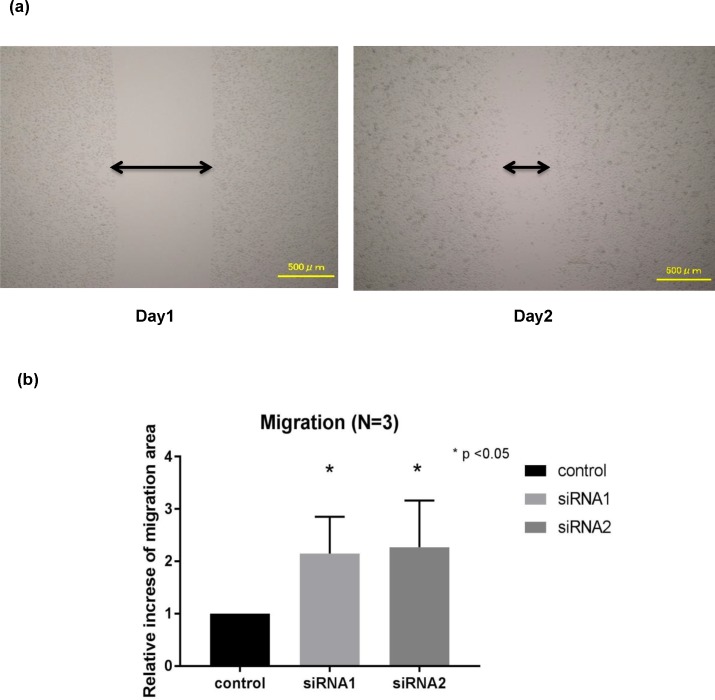
Migration assay in BAP1 knockdown GBC cell line.(a) A diagram immediately after scratching in the confluently cultured cells (day 1) and the narrowed gap by migrating cells (day 2) are shown. (b) The relative increase of the migration area compared to the control group after 24 hours was significantly higher in the BAP1 knocked-down cells.